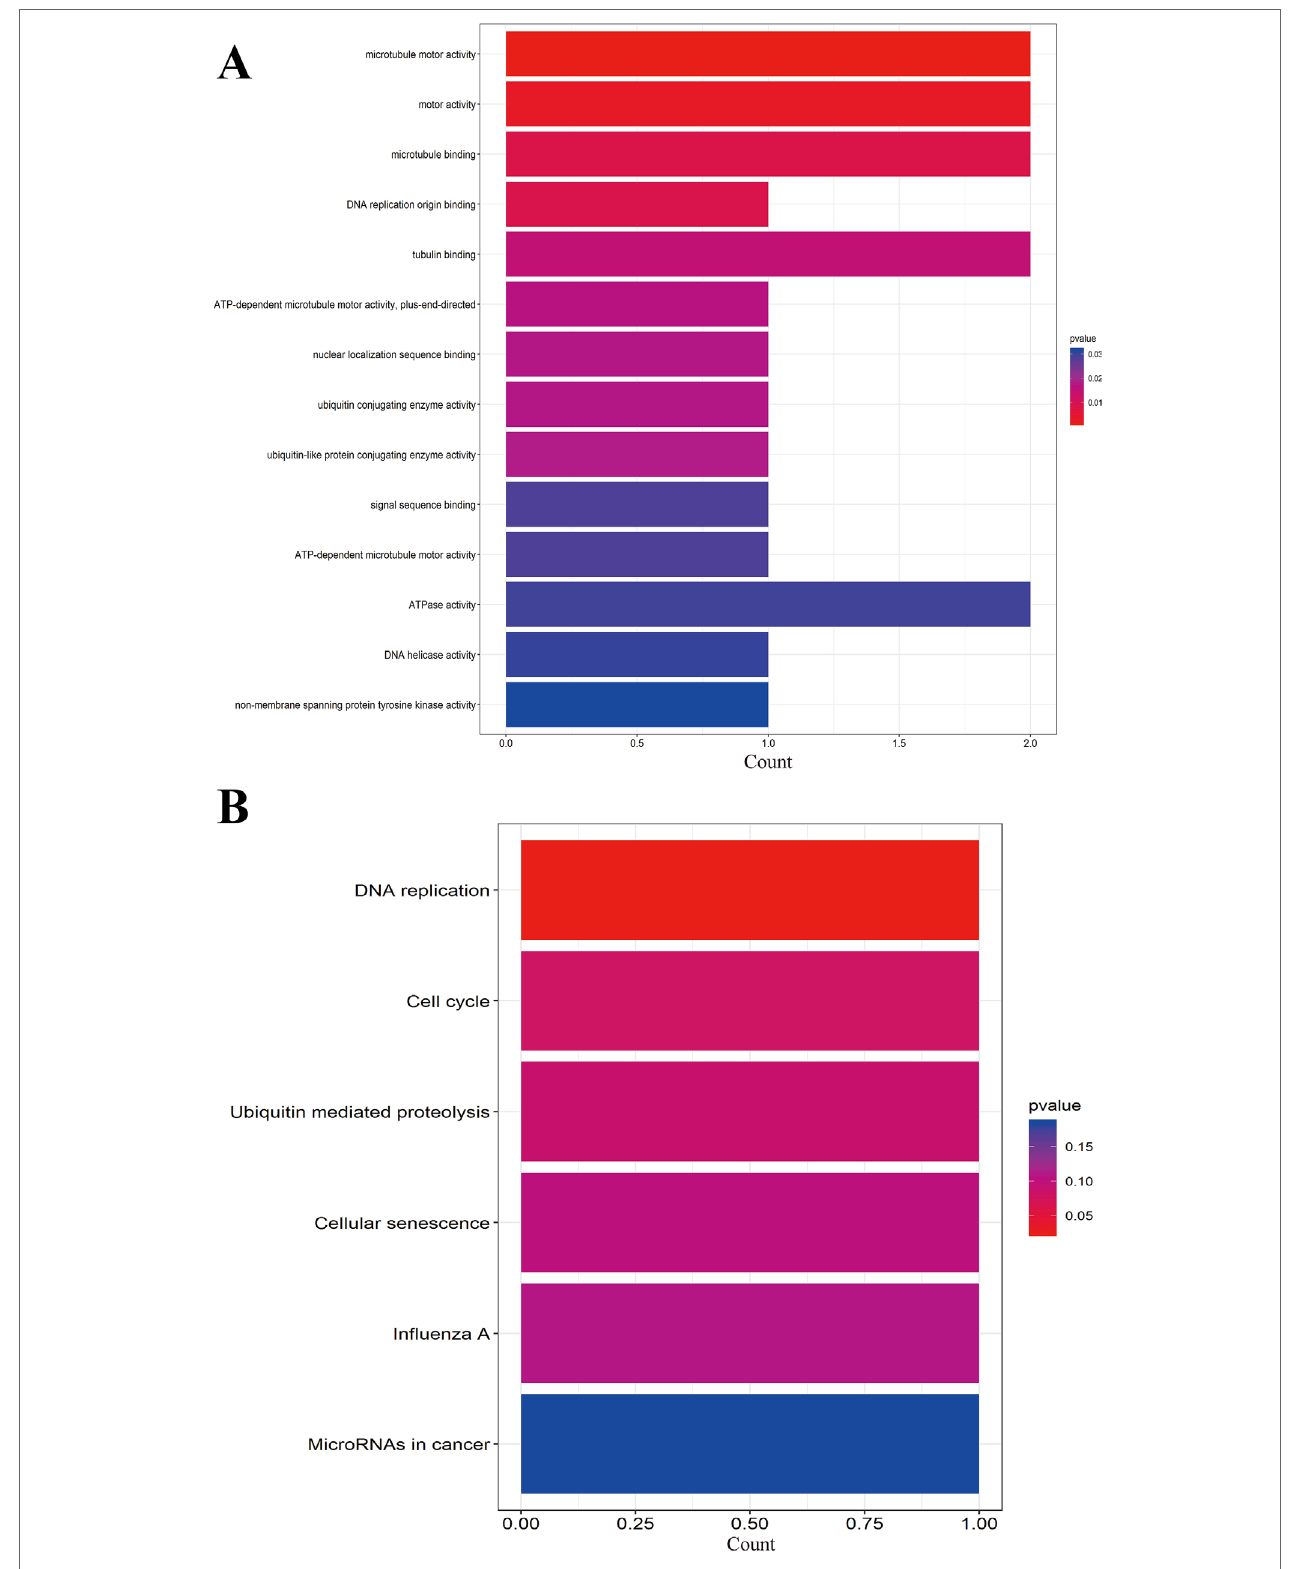
FIgUrE 7 | (A) GO analysis of these significant molecule in cluster 1. (B) KEGG analysis of these significant molecule in cluster 1.